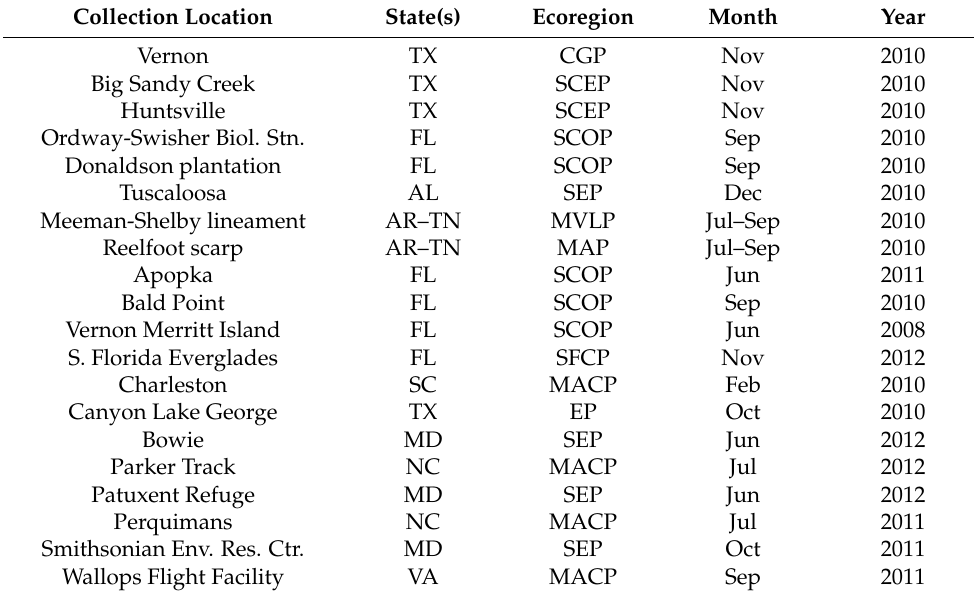
Table 3. Airborne lidar collection sources, states, ecoregions, and